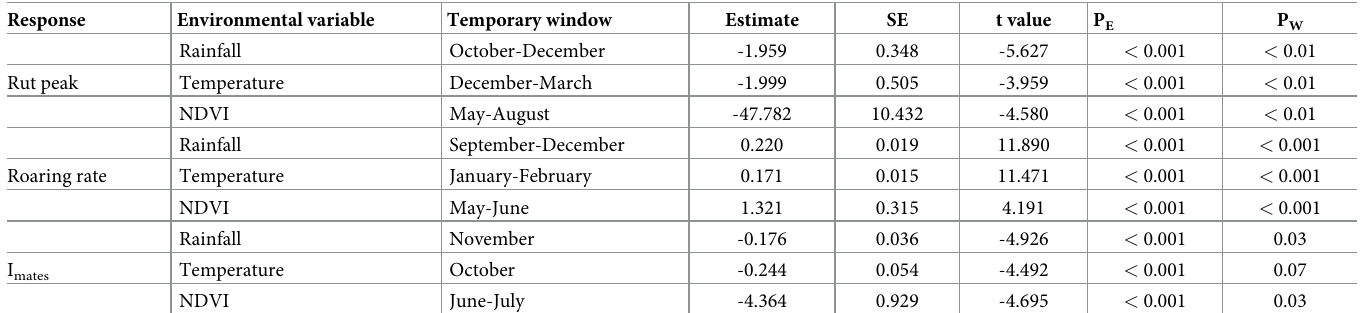
Table 1. Temporary windows of the environmental variables chosen following the sliding window analysis for the response variables rut peak, roaring rate and opportunity for sexual selection (I mates ) in the next September rutting season. The estimated effect of each climatic-factor window on the biological response variable is shown, with standard error (SE) ant a t value. P E is the p-value for the estimated linear effect of each climatic-variable window on the response variables, and P W is the p- value for window selection (obtained after 1000